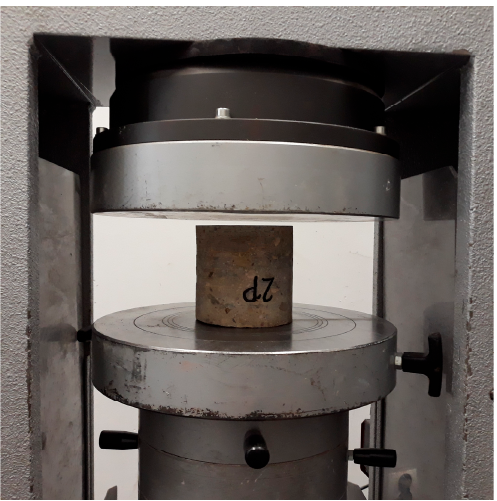
Figure 10. The locations in the building from which the concrete samples were taken for testing.